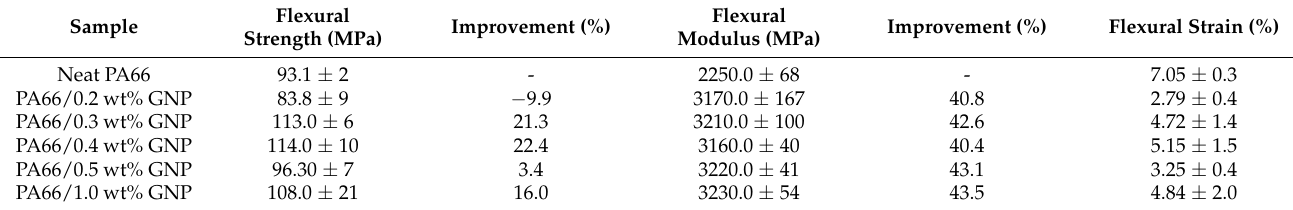
Figure 2. Flexural stress/strain curves of neat PA66 and its nanocomposites with different GNP loadings. Table 2. Improvement percentages of neat PA66 and PA66/GNP nanocomposites in flexural properties.